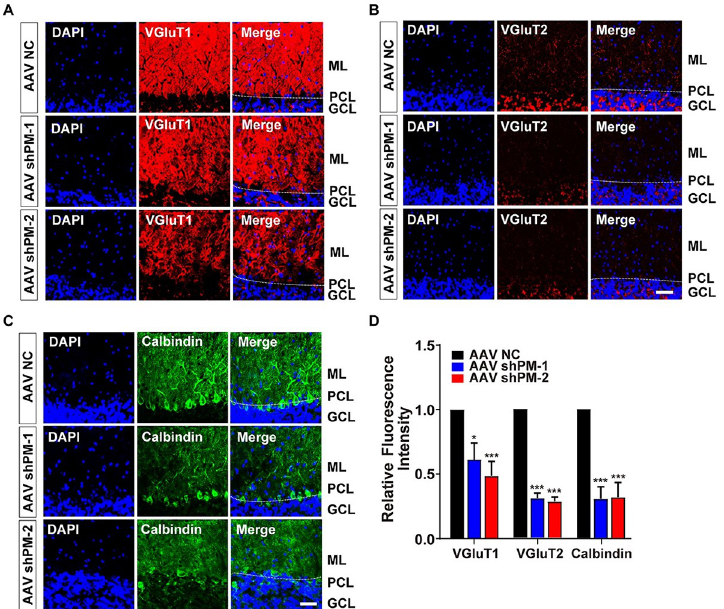
Fig 3. Reduced density of VGluT1, VGluT2, and Calbindin in the shPMs-injected mice. (A–C) Representative immunofluorescence images showed the density of VGluT1 (A), VGluT2 (B), or Calbindin (C) in the control and indicated sh PM s-injected mice. VGluT1, VGluT2, and Calbindin are markers for PF terminals, climbing fiber terminals, and PCs, respectively. (D) Quantification of the indicated markers obtained from A–C. All the data of this figure can be found in the S1 Data file. Data are shown as means ± SEMs, n = 3. Scale bar, 40 um. � P < 0.05 and ��� P < 0.001. GCL, granule cell layer; ML, molecular layer; PCL, Purkinje cell layer; PF, parallel fiber; VGluT1, vesicular glutamate transporter 1; VGluT2, vesicular glutamate transporter 2.